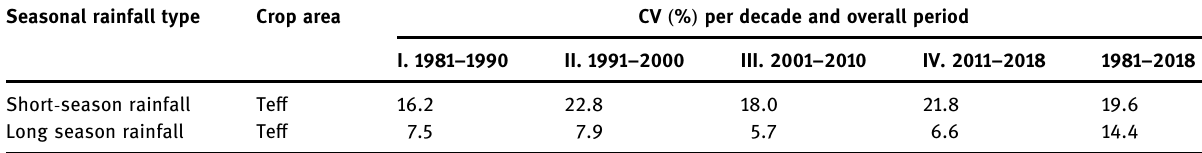
Table 5: Decadal CV% for short - and long - season rainfalls in te ff growing areas, 1981 – 2018 Seasonal rainfall type